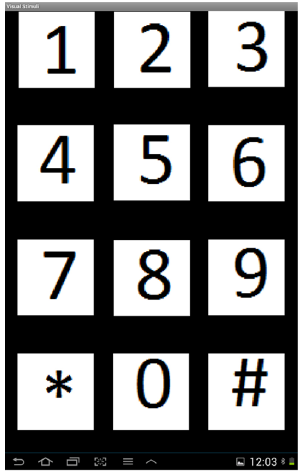
Figure 5. Screenshot of visual stimulus device.